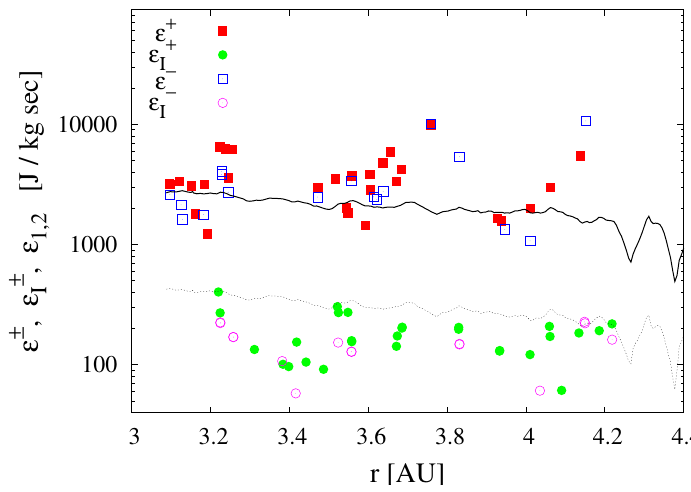
Figure 109: Radial profile of the pseudoenergy transfer rates obtained from the turbulent cascade rate through the Yaglom relation, for both the compressive and the incompressive case. The solid lines represent the radial profiles of the heating rate required to obtain the observed temperature